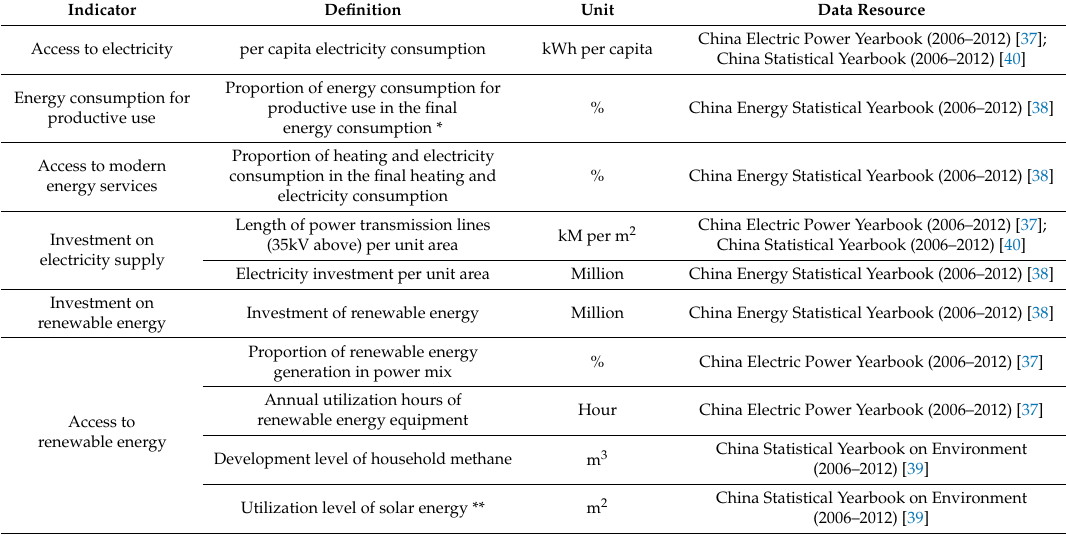
Table 1. Definition and data resources of